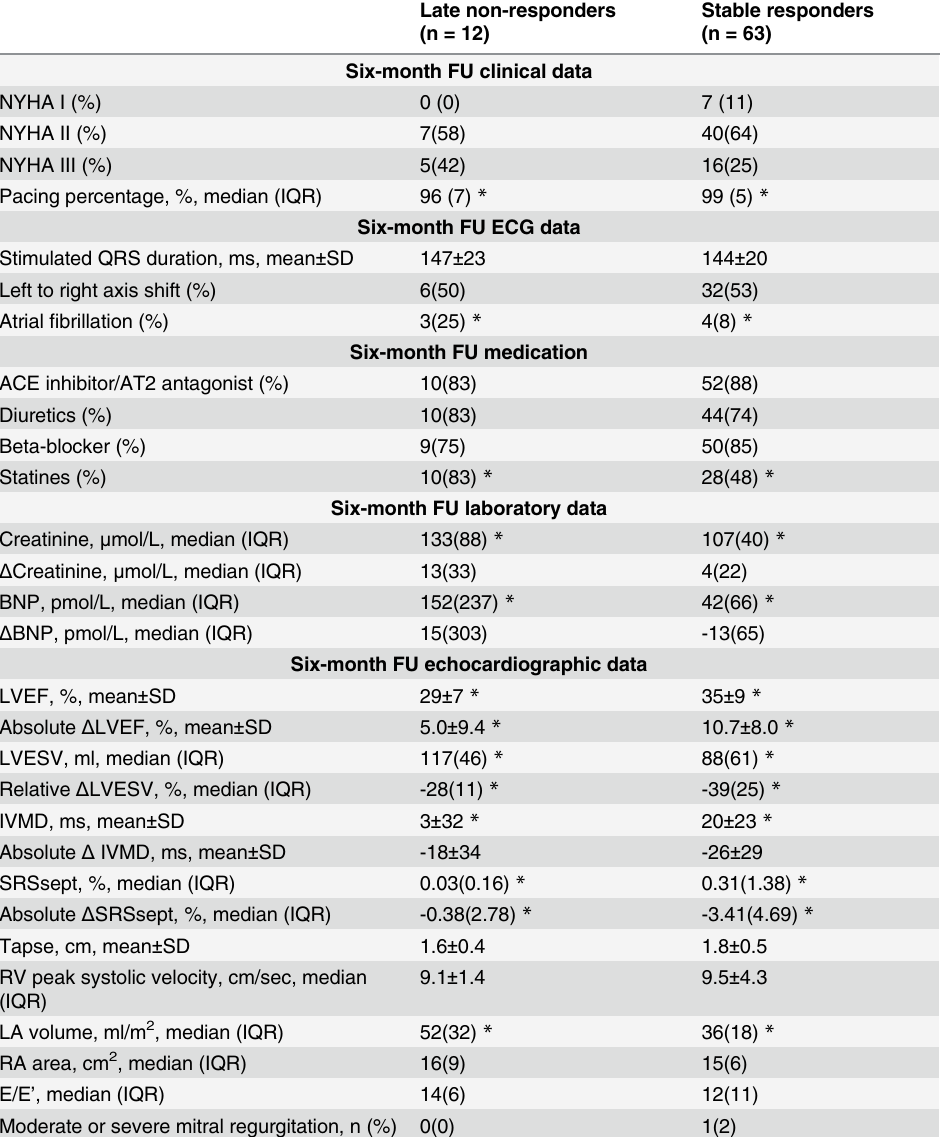
Table 2. Six-month follow-up data of late non-responders and stable